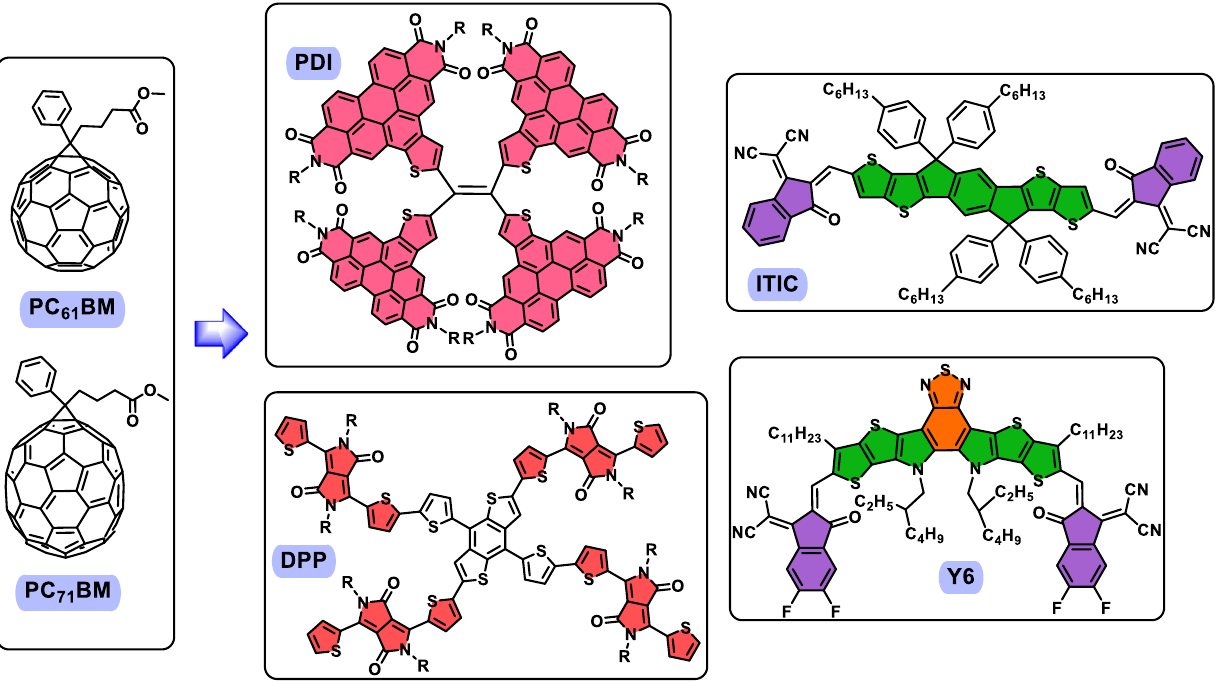
Fig. 1 Chemical structures of fullerenes (PC series (ITIC and